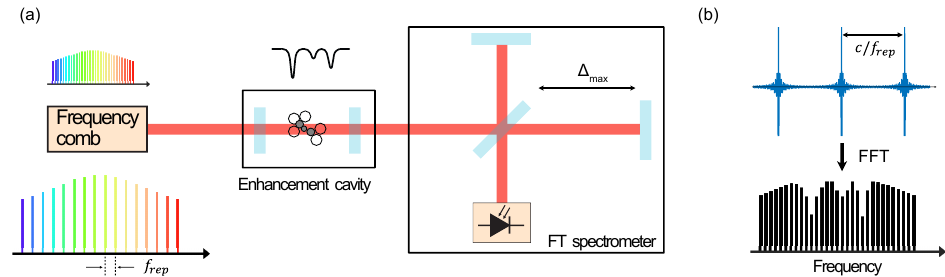
Figure 3. Setup of a comb based FTS. ( a ) A frequency comb with a repetition rate f rep interrogates a sample contained in an absorption cell, an enhancement cavity can be used to increase the effective absorption length. The light enters a Michelson interferometer where a measurement arm is translated over a scanning range ∆ max to produce and interferogram, ( b ), that consists of several bursts spaced by c / f rep . The Fourier transform of the interferogram yields the absorption spectra of the sample under